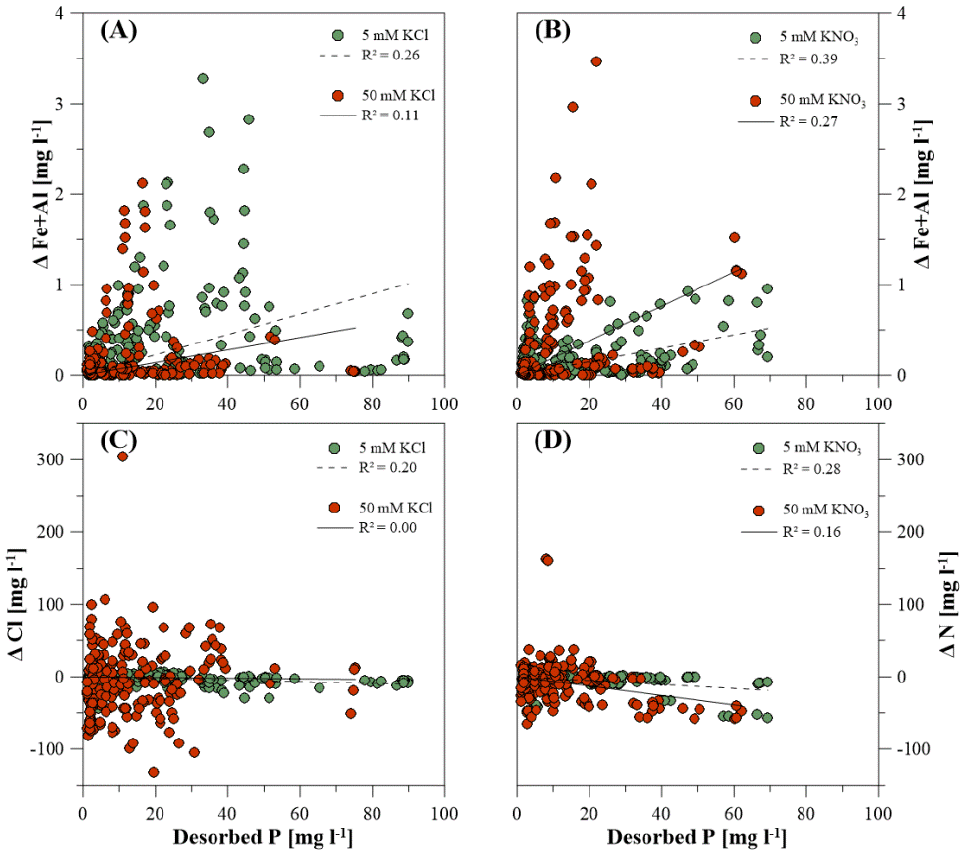
Figure 3. Correlation between desorbed P and the change of ( A ) dissolved total Fe + Al for KCl, ( B ) dissolved total Fe + Al for KNO 3 , ( C ) dissolved total Cl for KCl, and ( D ) dissolved total N for KNO 3 in the sample solution for all hydroxides and each desorption time step. The concentration of dissolved total Fe and Al (separately Fe or Al for the sole hy- droxides, sum of Fe and Al for the hydroxide-mixtures) showed enrichment in the sample solution during P desorption, however, the values had a high variation and no distinct cor- relation with the amount of desorbed P for the inorganic treatment (Figure 3A,B). While the KCl treatment with the lower 5 mM concentration had higher concentrations of dissolved total Fe and Al, the opposite was observed for KNO 3 . The same missing correlations of Fe, Al, and P were observed for the organic desorption treatments, whereas the concentration of dissolved Fe and Al increased in the sample solution as well. The Mal treatment showed higher concentrations of dissolved total Fe and Al than His (Figure